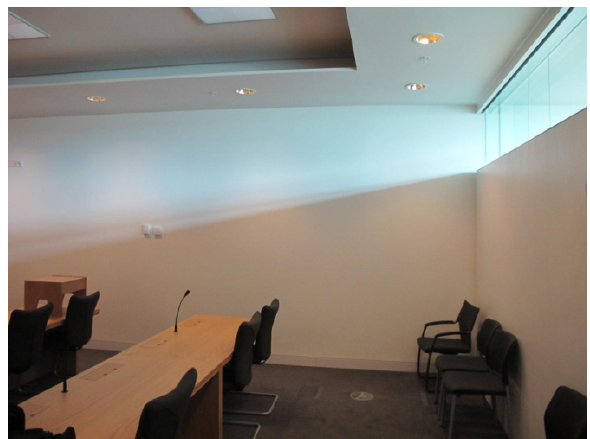
Figure 12. Lower Court